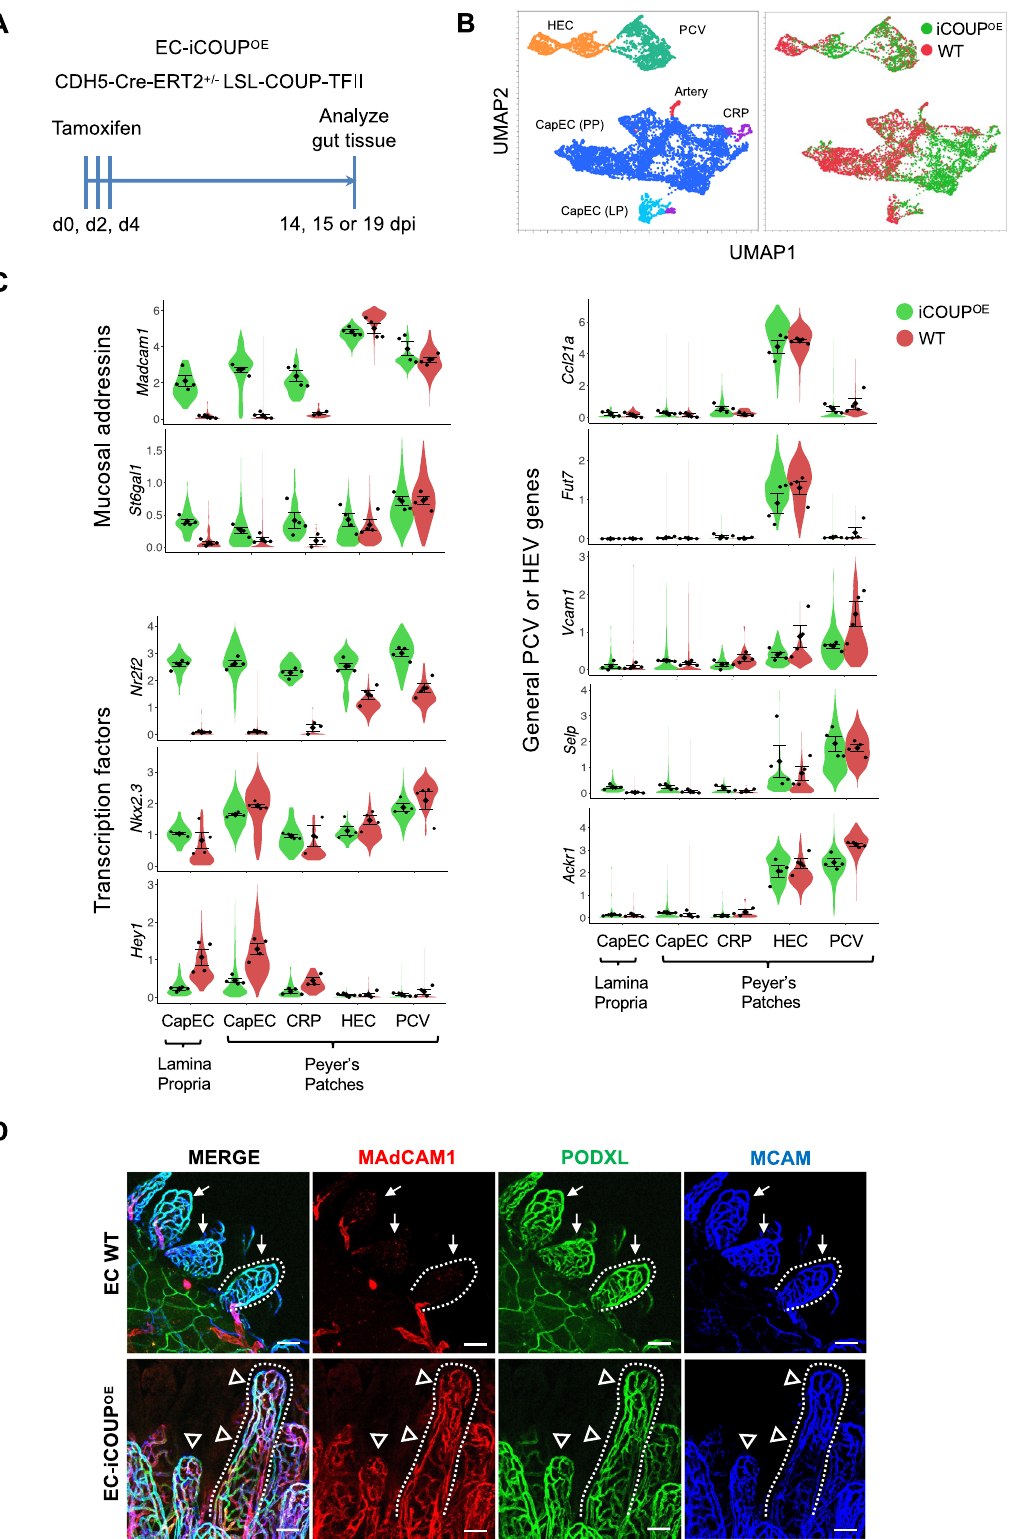
Fig. 4 | Pan-endothelial COUP-TFII expression induces ectopic Madcam1 and St6gal1 in intestinal capillaries. A Experimental timeline for induction of COUP- TFIIinEC. B UMAPplotofPPBECcoloredbyECsubset(left)orbygenotype(right). C Violin plots showing expression of select genes in EC-iCOUP OE vs control BEC subsets. Dots represent mean gene expression of separate cohorts (male and